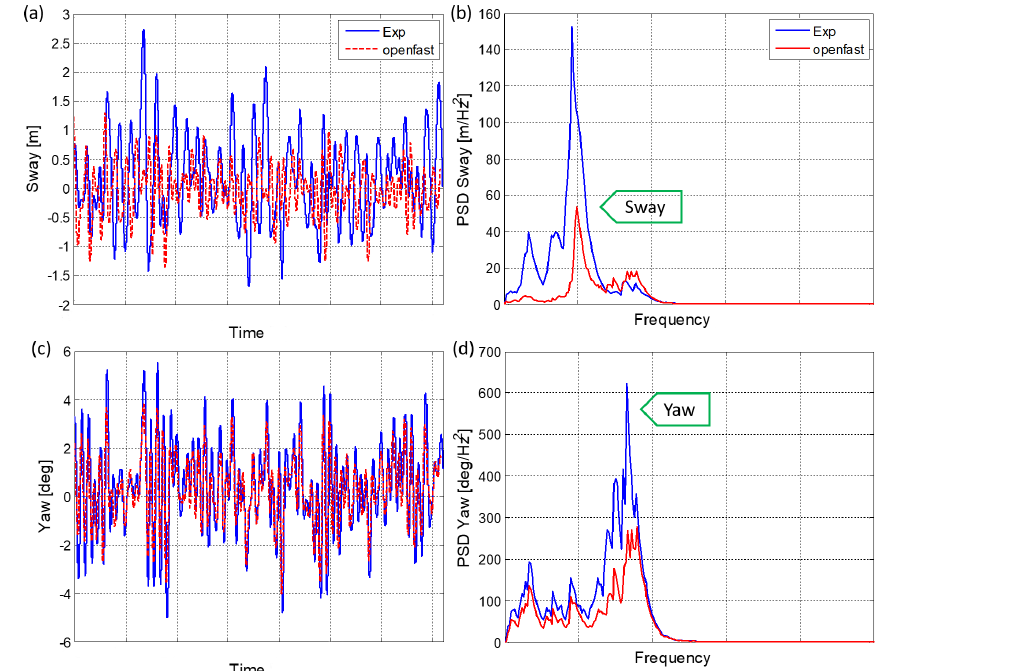
Figure 8. Platform response comparison between experiments and computations of sway and yaw under 7.5ms − 1 turbulent mean wind speed without waves. (a) Sway response in time domain, (b) sway response PSD, (c) yaw response in time domain and (d) yaw response